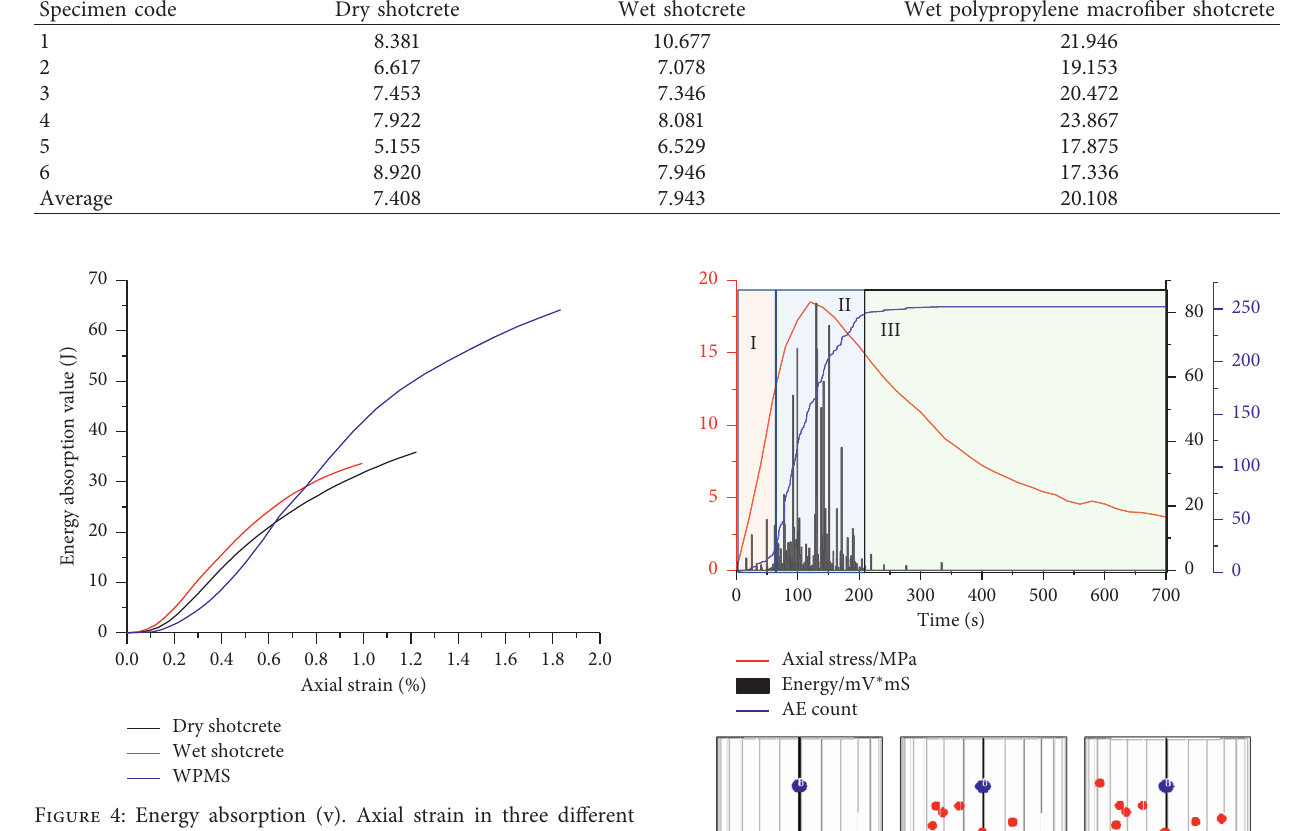
Table 4: Energy absorption at time of failure for three different shotcrete mixes (MPa).